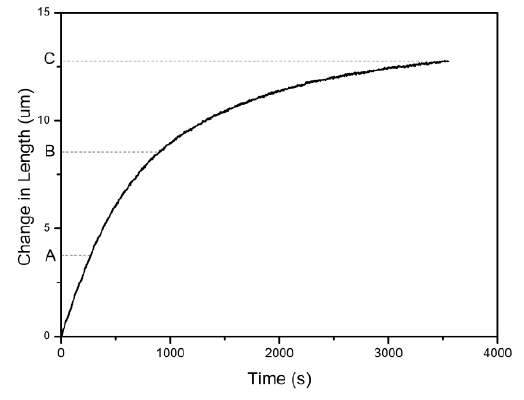
Figure 3. Expansion curve at 270 °C.